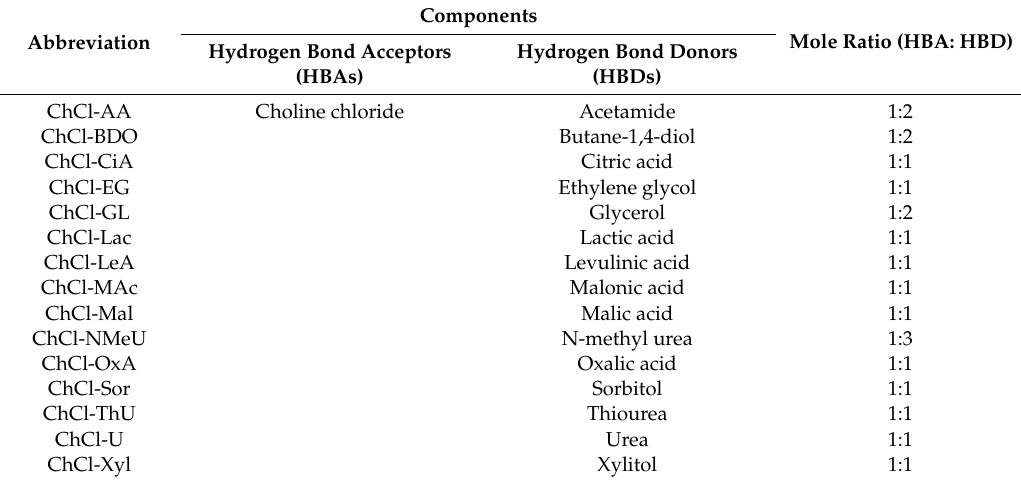
Table 1. List of DESs prepared and tested for the extraction of hesperidin from mandarin